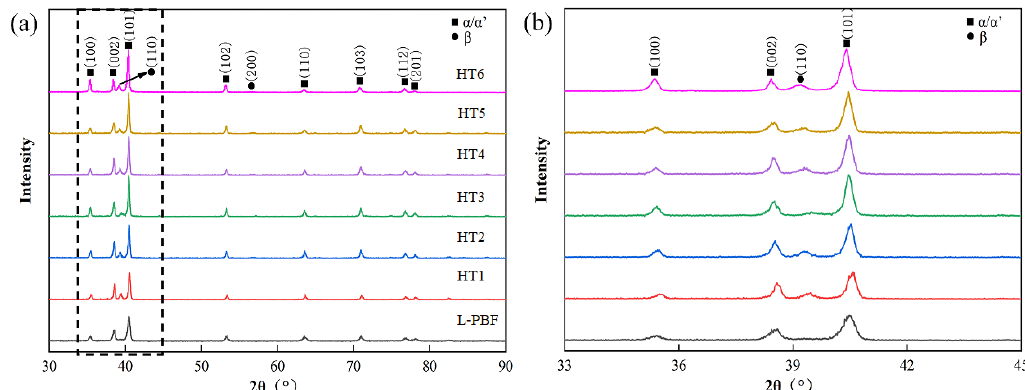
Figure 2. ( a ) XRD pattern of the L-PBF TA15 before and after annealing, ( b ) details within the black dotted lines in ( a ). Table 3. FHWM at different annealing temperatures (2 θ ~40.5 ◦ C) and the lattice constant of the β phase at various heat